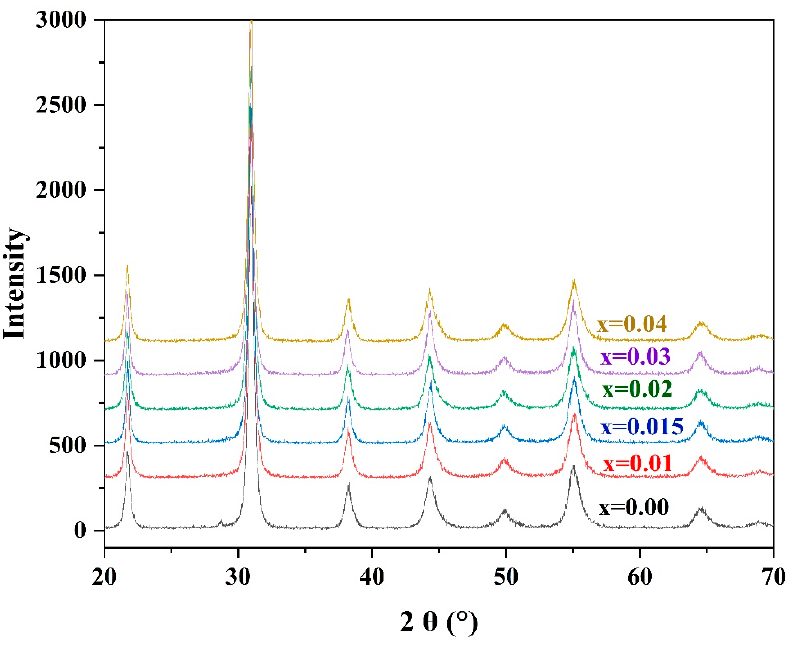
Figure 3. XRD patterns of PZTN powders synthesized at 740 °C for 4 h.